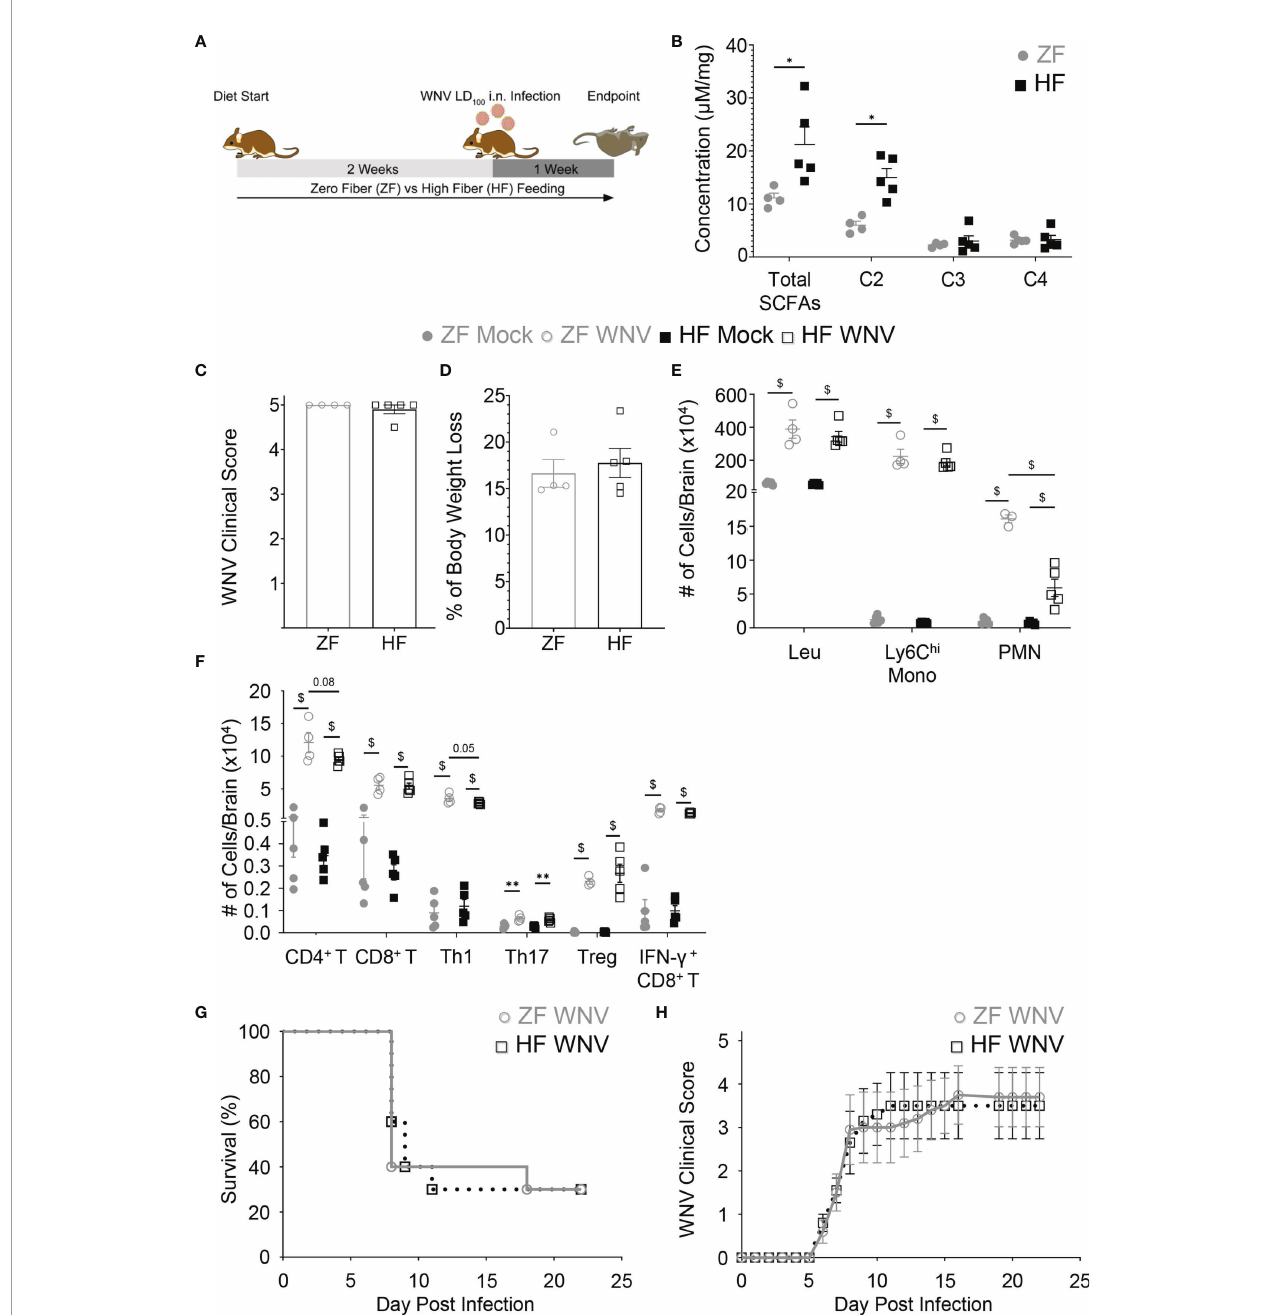
FIGURE 1 | Dietary fi ber increased fecal acetate but failed to protect against WNV encephalitic neuroin fl ammation and improve disease survival. Mice were fed on diets either enriched (HF) or de fi cient (ZF) in dietary fi ber for two weeks and then intranasally infected with either LD 100 (A – F) or LD 50 WNV (G, H) , while diets were maintained during infection. (A) Experimental work fl ow for LD 100 WNV infection study. (B) The concentration of fecal total SCFA, acetate (C2), propionate (C3) and butyrate (C4) of mice fed on HF or ZF diet for two weeks was quanti fi ed by NMR spectroscopy (n = 4-5 per group). Clinical scores (C) and body weight loss (D) of ZF- or HF-diet-fed mice in WNV LD 100 study were determined at 7 dpi (n = 4-5 per group). (E) Numbers of total leukocytes (Leu), Ly6C hi monocytes (Ly6C hi Mono), and neutrophils (PMN) in mock-infected (Mock) or 7 dpi LD 100 WNV-infected (WNV) brain from mice fed on ZF- or HF-diets were analyzed by fl ow cytometry (n = 4-5 per group). (F) Numbers of CD4 + T cells, CD8 + T cells, Th1, Th17, Treg, and IFN- g + CD8 + T cells in mock-infected (Mock) or 7 dpi LD 100 WNV-infected (WNV) brain from mice fed on ZF- or HF-diets were analyzed by fl ow cytometry (n = 4-5 per group). (G) Survival of mice intranasally infected with LD 50 WNV fed on ZF- or HF- diets (n = 10 per group). (H) Average clinical scores of LD 50 -infected mice fed on ZF- or HF-diets (n = 10 per group). Data are represented as mean ± SEM with ∗ p < 0.05; ∗∗ p < 0.01 and $ p < 0.001 by t test or two-way